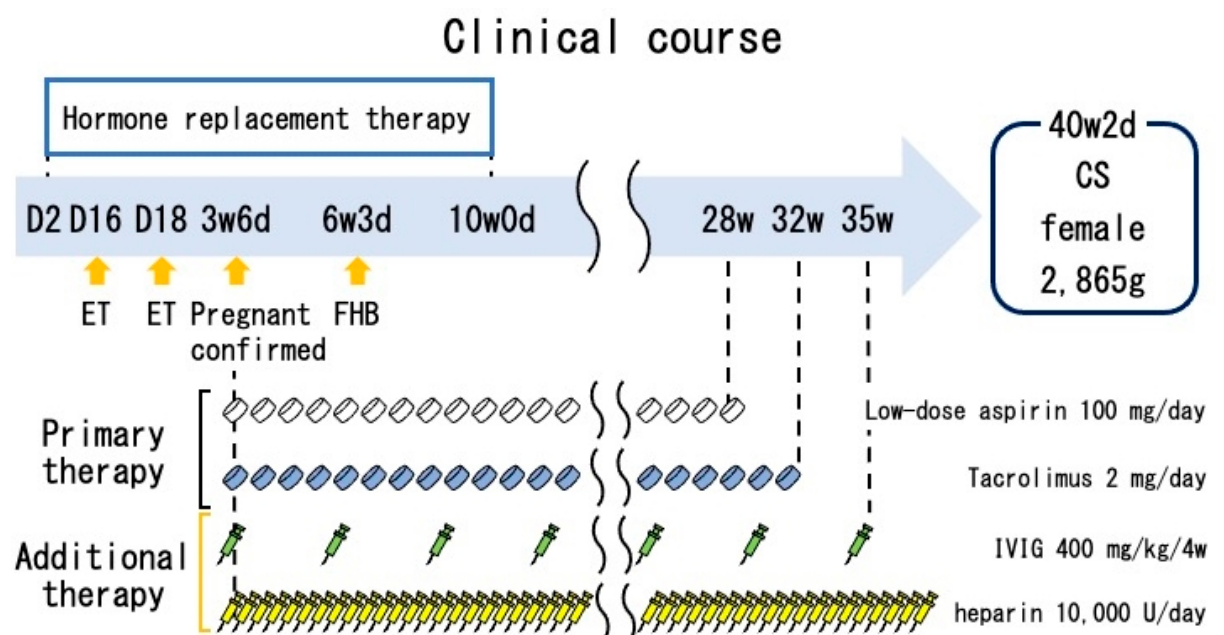
Figure 1. The successful clinical course of this case at the second embryo transfer. At the first embryo transfer, she was administered with LDA and tacrolimus. Considering additional results of examinations, at the second embryo transfer, she was administered with IVIG and UFH added to primary therapy. CS: cesarean section, ET: embryo transfer, FHB: fetal heartbeat.